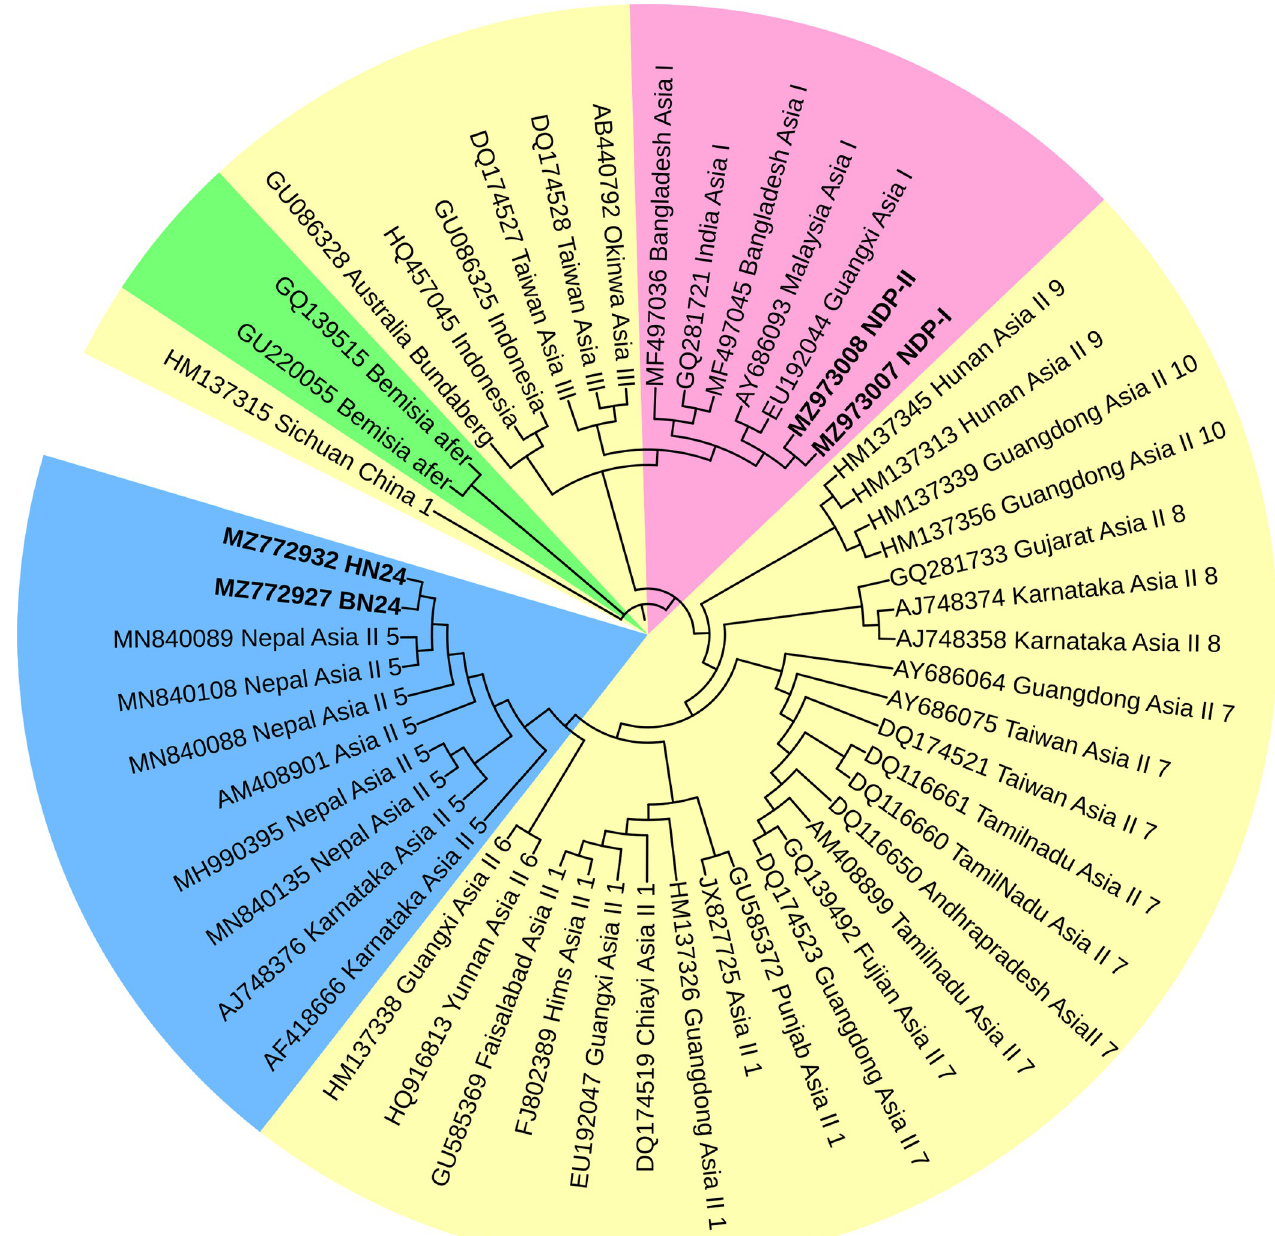
Fig 1. Phylogenetic tree of B . tabaci cryptic species identified based on cytochrome oxidase subunit I (COI) sequences. The samples from the study are indicated by bold text in the tree; all other sequences were obtained from the GenBank database. Pink and blue coloured shade represent sequences of Asia I and Asia II 5 respectively, whereas, yellow shade represent the other cryptic species of B . tabaci . Bemisia afer sequences (green shade) was taken as an